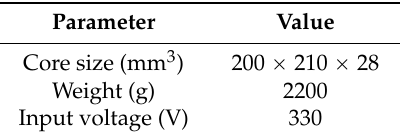
Figure 1. Modularized and integrated high-voltage heating system. Table 1. Specifications of the high-voltage heating system.